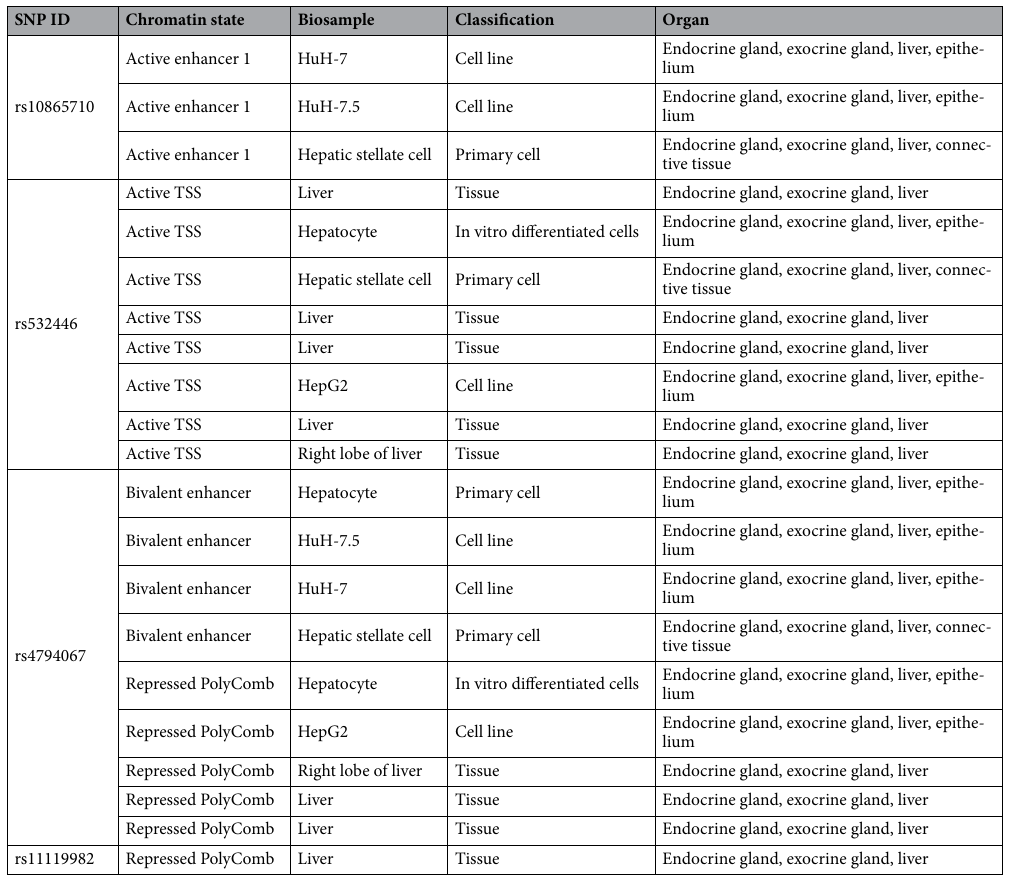
Table 8. Key histone modification analysis results restricted to liver organ obtained by RegulomeDB. TSS transcription start site.